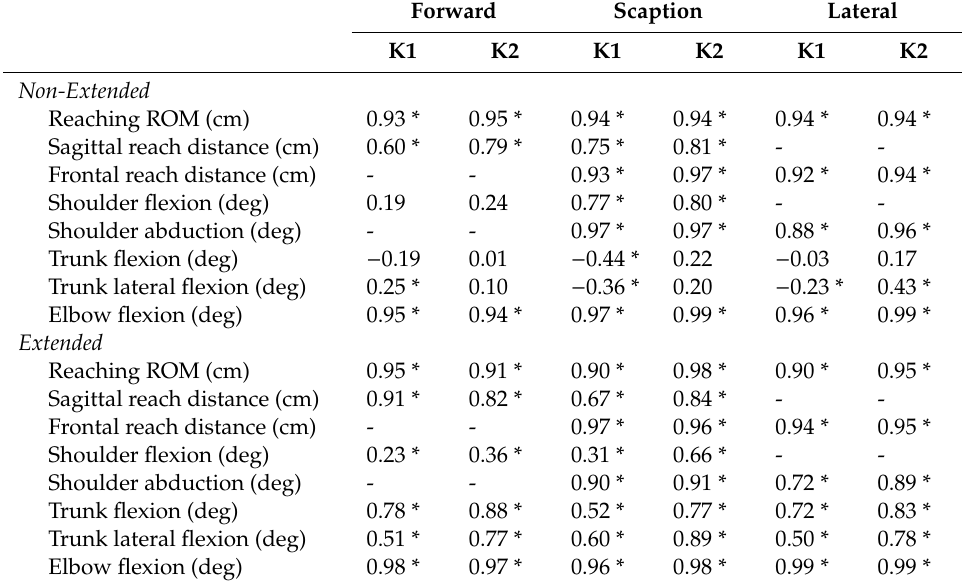
Table 2. Validity measured by Pearson’s correlation coe ffi cients (r) between the K1 and VMC and the K2 and VMC on D1.